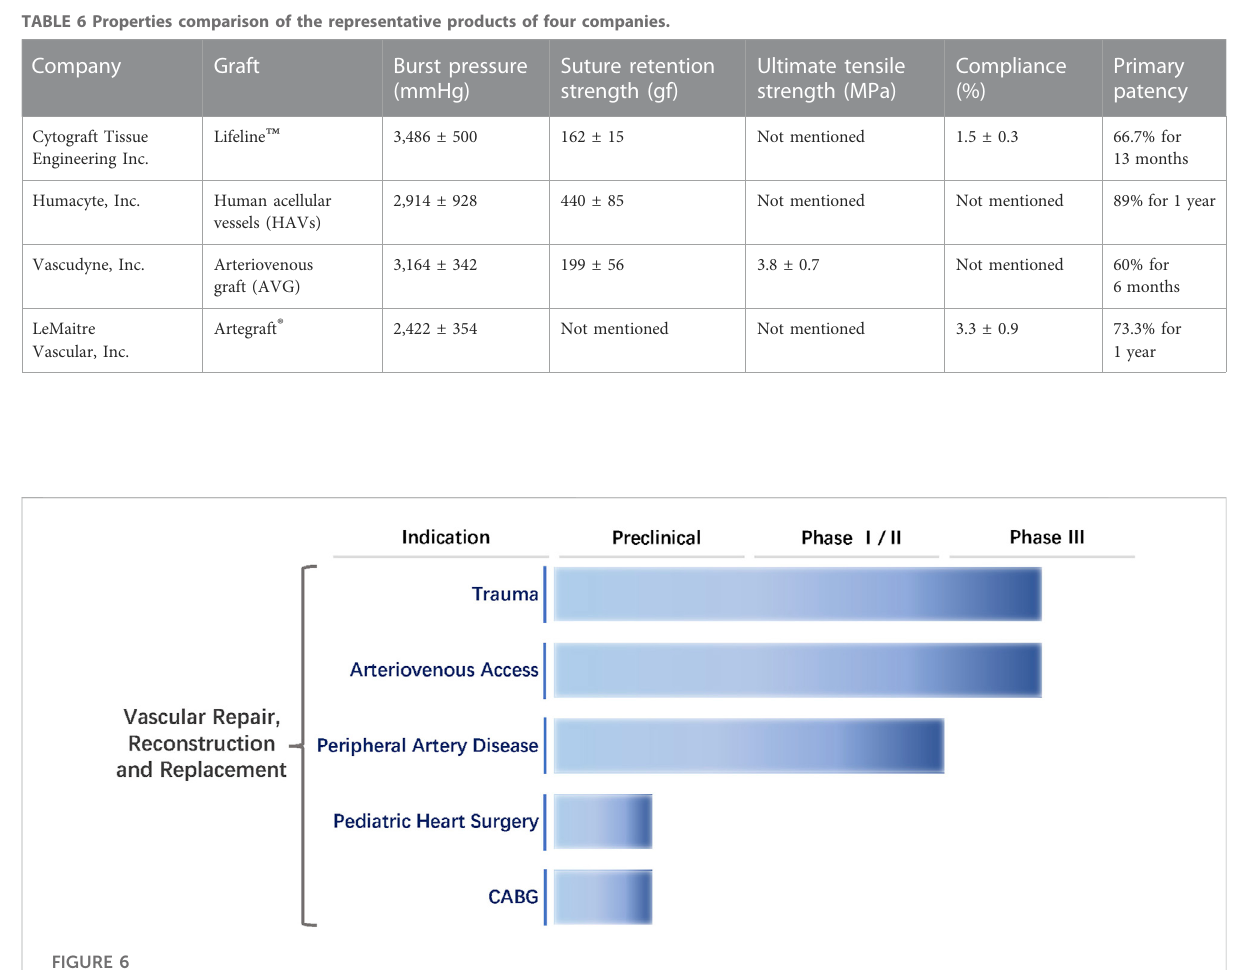
TABLE 6 Properties comparison of the representative products of four companies. Company Graft